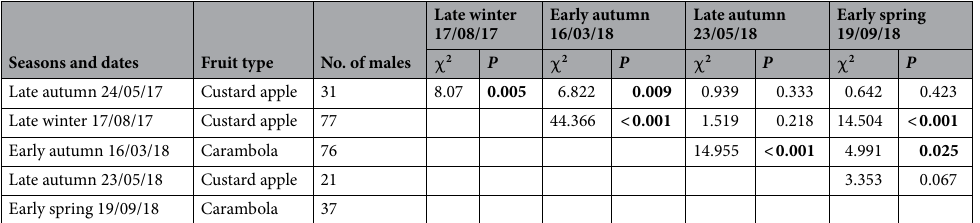
Table 1. A pairwise comparison of survival function of five cohorts of adult male Bactrocera tryoni that emerged in the laboratory from field infested fruit (= reference cohorts) collected during different seasons in 2017–18 from a site in subtropical Australia. Bold values indicate significant difference at P < 0.05. In the laboratory flies were held at 27 °C constant temperature and had ad libitum access to water and food.